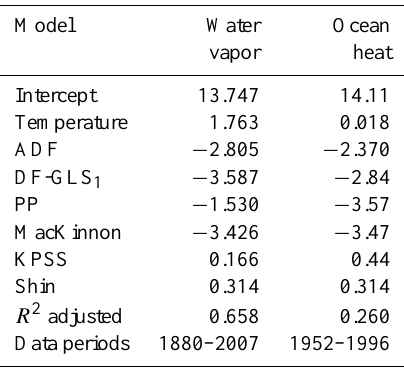
Table 4. Water vapor and ocean heat: cointegration tests with